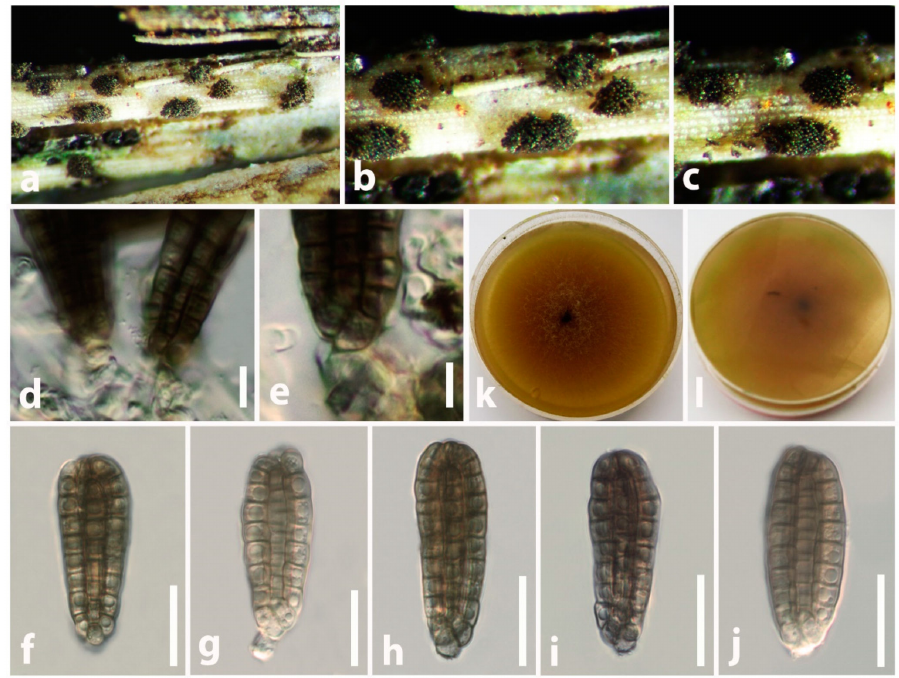
Figure 3. Dictyocheirospora garethjonesii (CMUB 39982, new host record ). ( a ) Sporodochia on dead stem of Bismarkia nobilis . ( b , c ) Close-up of Sporodochia. ( d , e ) Conidiogenous cells with developing conidia. ( f – j ) Conidia. ( k ) Colonies from above (on PDA/4 weeks). ( l ) Colonies from below (on PDA/4 weeks). Scale bars: ( d , e ) = 4 µ m and ( f – j ) = 20 µ m. Saprobic on the decaying stem of Bismarkia nobilis Hildebr. and H.Wendl. (Arecaceae). Sexual morph : Undetermined. Asexual morph : Hyphomycetous. Colonies 130–270 µ m in diameter ( x = 210 µ m, n = 20), on natural substrate forming sporodochial